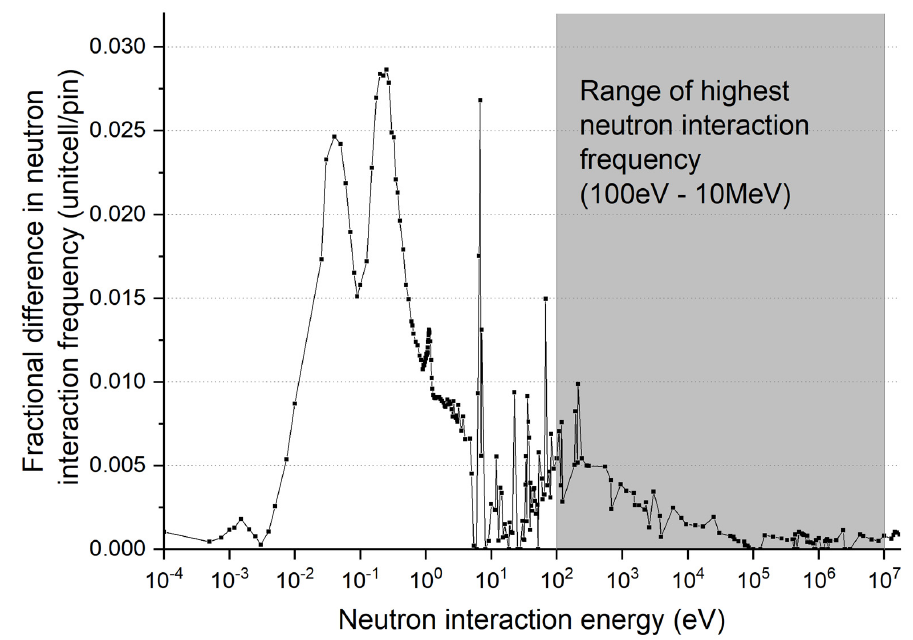
Figure 9. Fractional difference in neutron interaction frequency between the unit cell and RPT pin models calculated across a 238-energy group spectrum. In the energy range of highest interaction frequency for this pin, agreement of within 1% is seen between the axial and transformed radial models. Outside of this most-frequent range, higher discrepancies between the models can be found but very few interactions between neutrons of energies lower than 100 eV take place in the breeder reactor, as can be seen in Figure 8. Fractional difference is calculated using ( unitcell − pin ) 2 to normalise values for energy groups of lower interaction